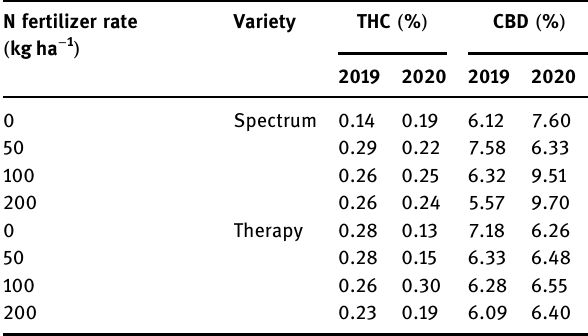
Table 4: Mean concentrations of tetrahydrocannabinol ( THC ) and cannabidiol ( CBD ) following di ff erent rates of nitrogen ( N ) fertili - zation for two CBD hemp varieties